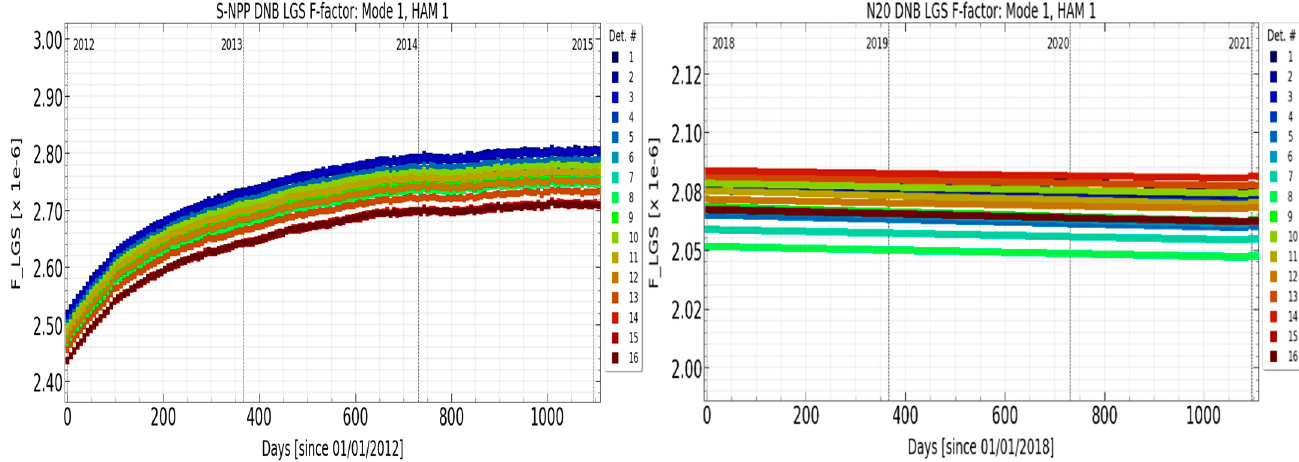
Figure 12. SNPP and NOAA-20 VIIRS DNB F-factor comparisons in the case of LGS mode-1 at HAM-1. DNB 16 detectors are plotted in different colors.